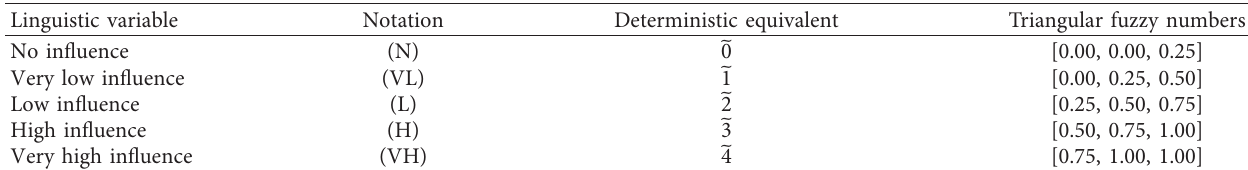
Table 5: The linguistic variables used and their corresponding fuzzy